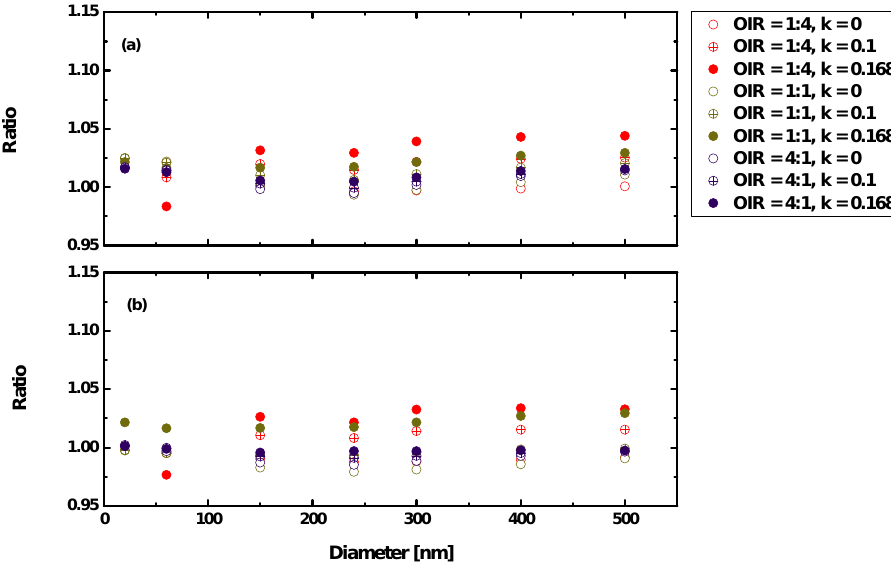
Figure 10. Ratio of radiative forcing of LLPS to the homogenous case under 70%RH (a) and dry conditions (b) for AAE = 6 and albedo a =